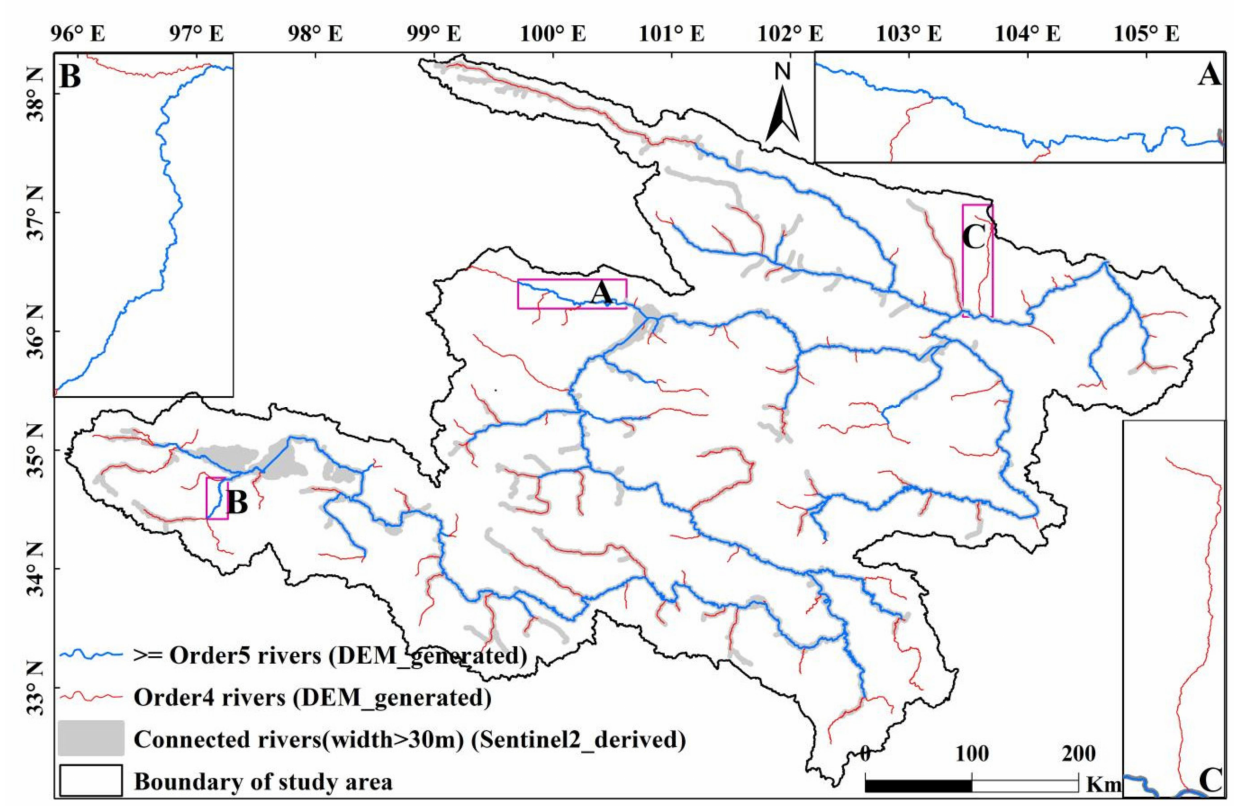
Figure 6. Comparisons between the extracted connected rivers with a width over 30 m and river networks above order 3 that were generated from a 90-m resolution